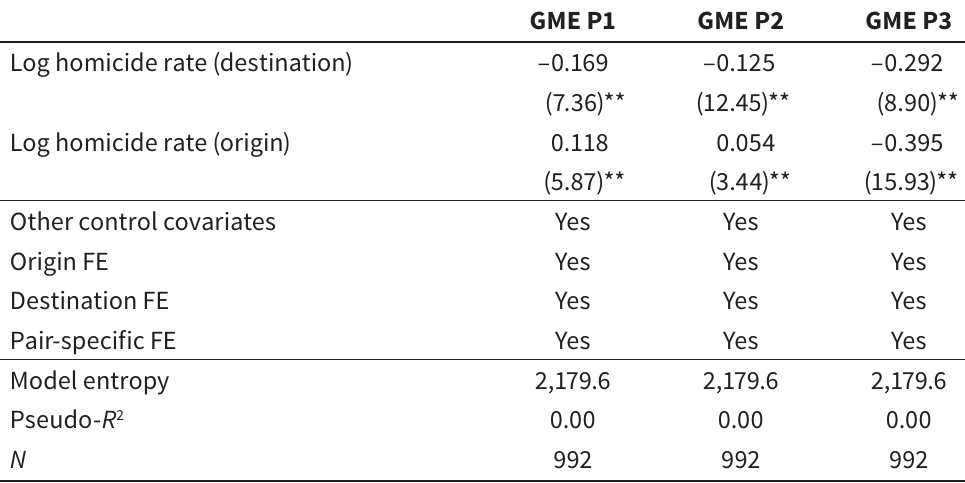
Estimation of gravity model (GME 3FE) per